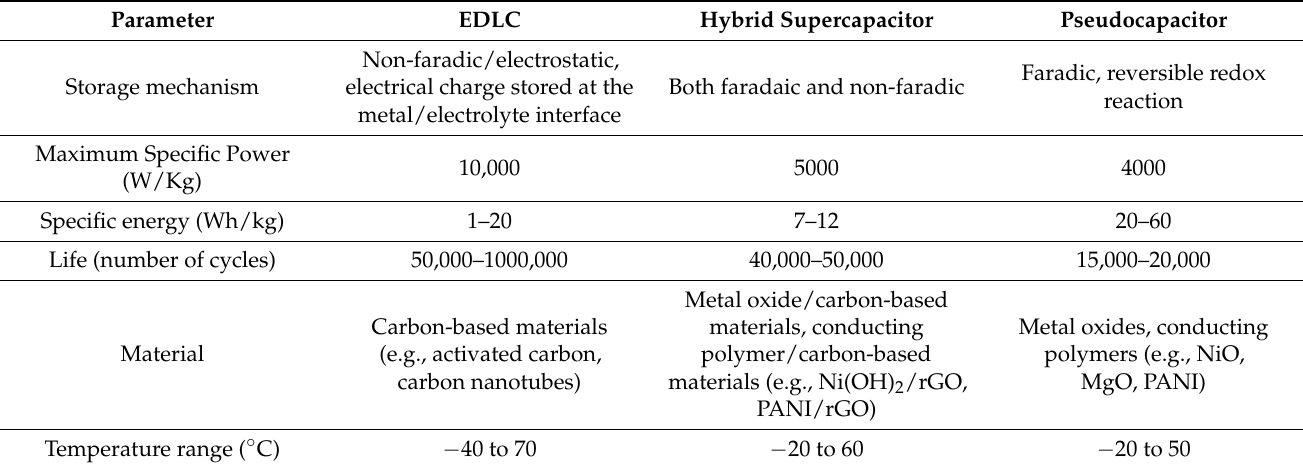
Table 2. Comparison of EDLC and other supercapacitor types